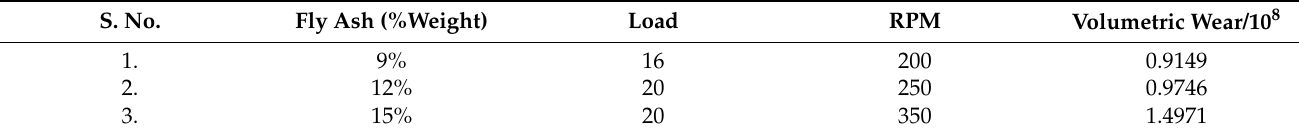
Table 11. Experiments for